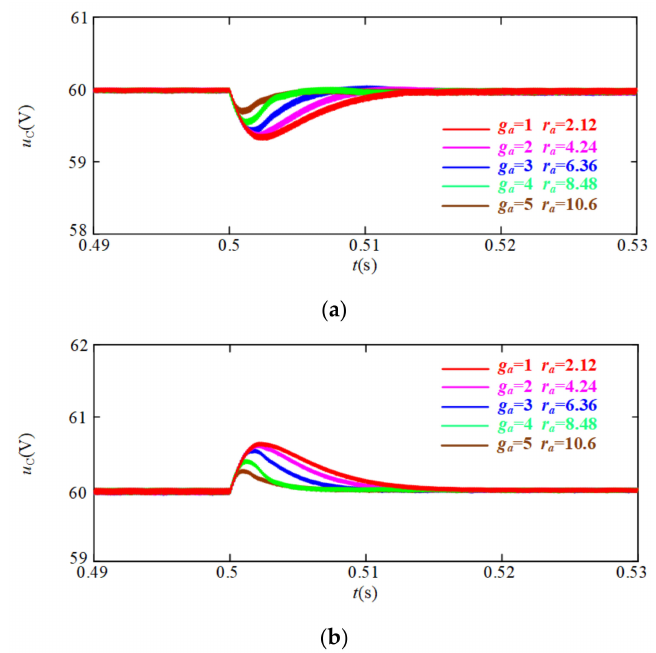
Figure 9. Simulated u C responses of the different g a and r a when CPL steps up and down. ( a ) CPL: 60 W to 90 W; ( b ) CPL: 90 W to 60